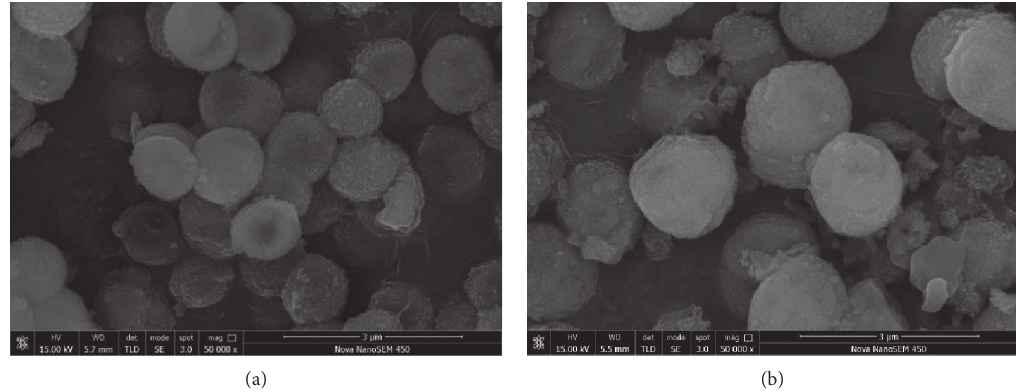
Figure 8: SEM spectra of the two samples. (a) Mineralization materials of sample 1. (b) Mineralization materials of sample 2.